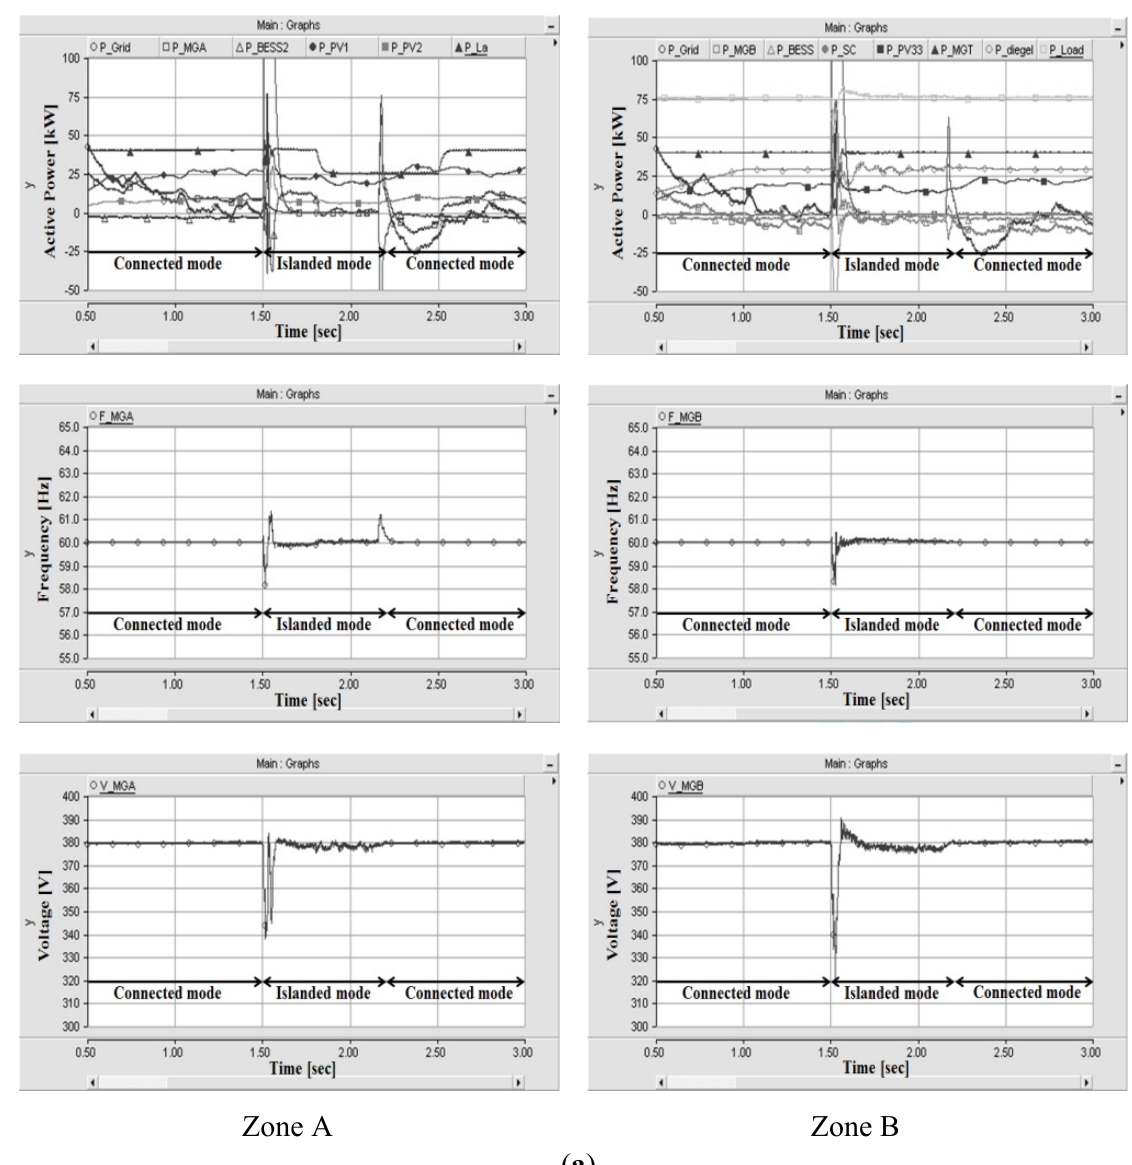
Figure 9. Active power, frequency and voltage in microgrid (Zones A and B) about Case 7, 8 and 9 respectively. ( a ) Case 7, Common Line Fault with Relay Setting: 2.0~3.0 pu (Adequate); ( b ) Case 8, Common Line Fault with Relay Setting: 1.0~1.1 pu (Low); ( c ) Case 9, Common Line Fault with Relay Setting: 7.0~8.0 pu